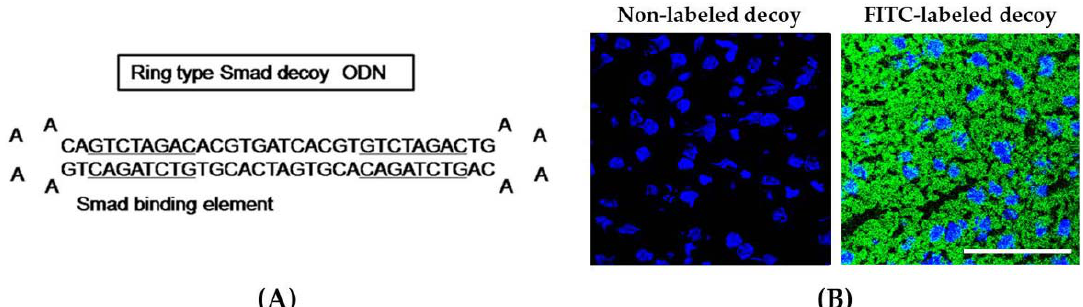
Figure 1. Synthesis of Smad decoy oligodeoxynucleotide (ODN) and transfection of Smad decoy ODN into mouse liver. ( A ) Design of ring-type Smad decoy ODN including GTCTAGAC, which is the consensus sequence for the Smad-binding element; ( B ) immunofluorescence image of the transfer effect of Smad decoy ODN in liver of mice. The image on the left is the result of administration of nonlabeled ODN, and on the image on the right, green fluorescence represented successful transfection into mouse liver. Scale bar, 50 μ m.